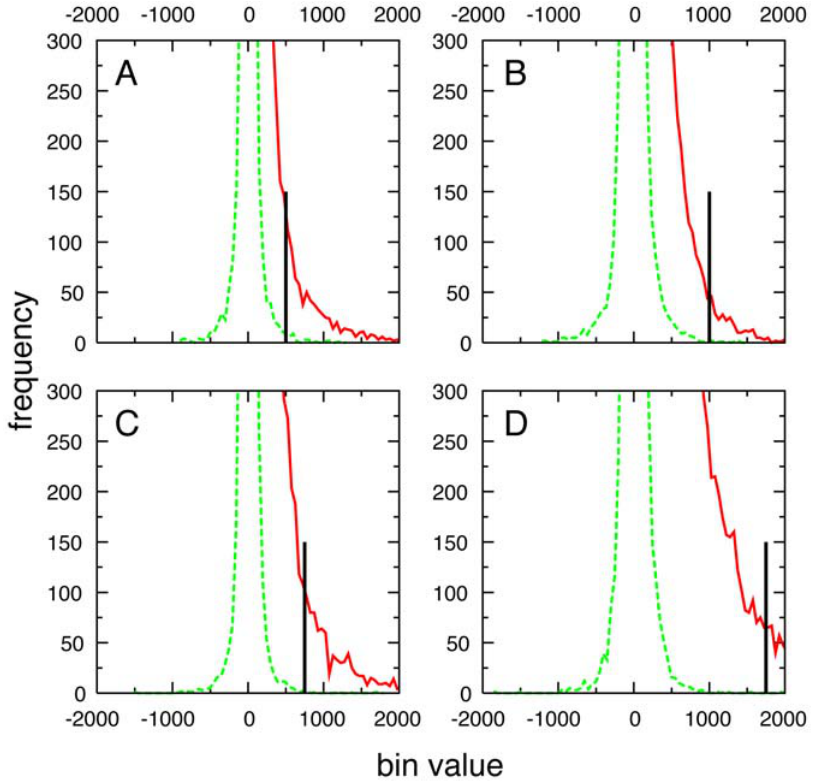
Figure 3. Frequency histograms of FragMap (solid red) and difference map (dashed green) bin counts for (A) aliphatic carbons, (B) aromatic carbons, (C) hydrogen bond donors, and (D) hydrogen bond acceptors. Solid black vertical lines are located at the isocontour value used for visualizing FragMaps (Figures 4–6).